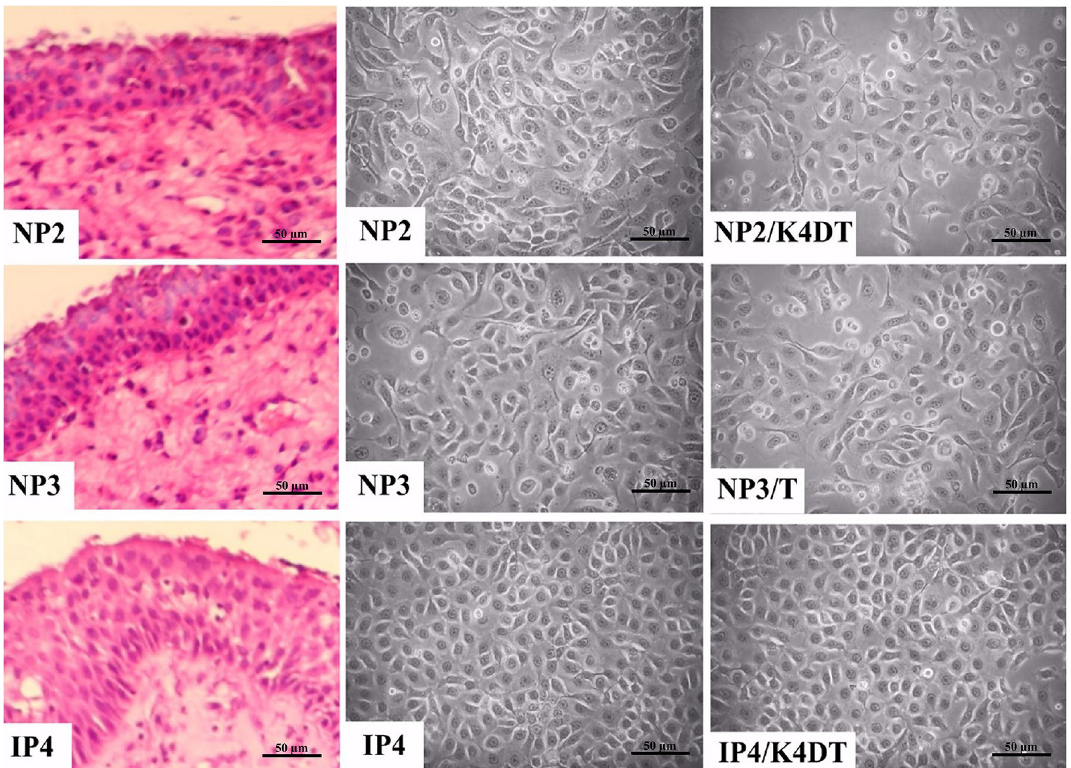
Figure 1. Photomicrograph of a representative H&E stained paraffin section of the original primary tumor (left), and the polygonal morphology of established primary cells (middle) and primary immortal cells (right). The primary cells, NP2, IP4, and NP3 were transduced with a combination of CDK4R24C, cyclin D1, and TERT or TERT alone, respectively, to obtain primary immortal cells. All established cells were cultivated in FYAD- medium in cell-culture flasks and incubated in 5% CO 2 at 37 °C. At the 70–90% confluence, all established cells showed a similar morphological character to their primary tumor cells. Images were taken under the microscope with 200 × magnification (scale bars: 50